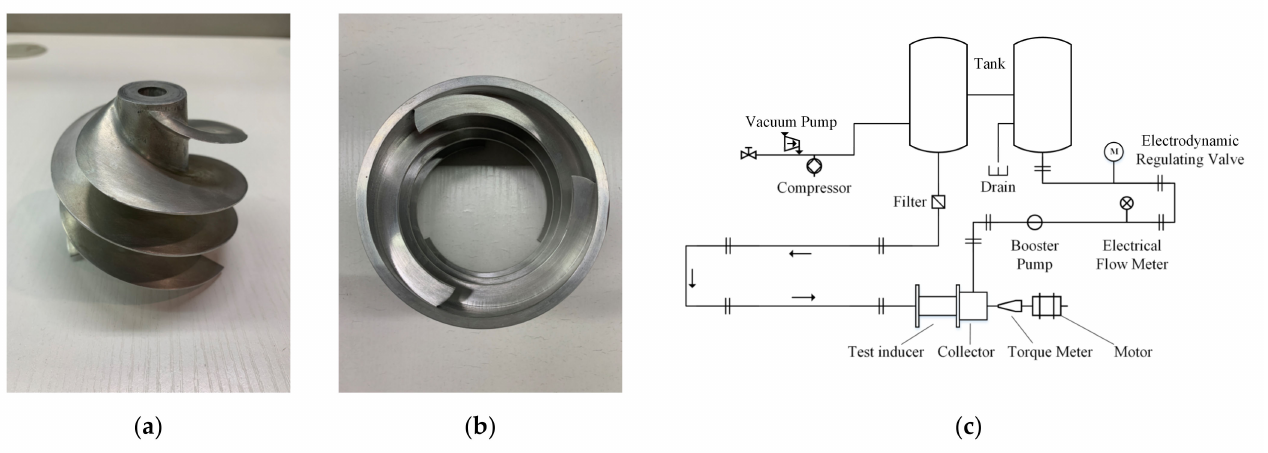
Figure 4. Pictures of test object and experimental system. ( a ) Inducer, ( b ) helical static blades, ( c ) experimental